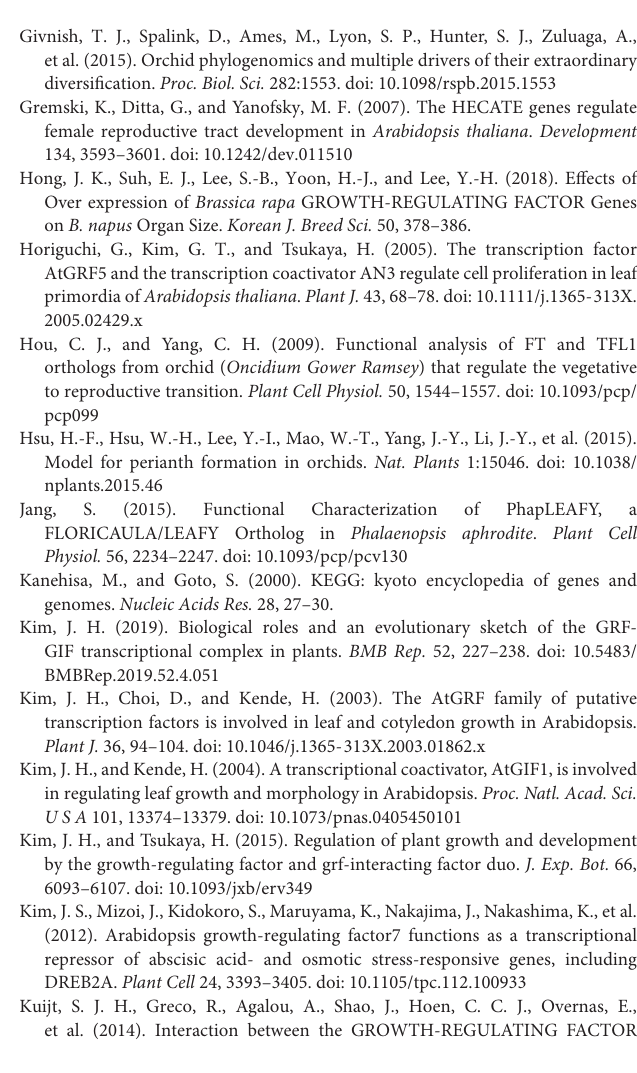
Supplementary Figure 1 | Floral development process of Cymbidium ensifolium. Supplementary Figure 2 | Comparative transcriptome analysis of individual floral Organs. (A) Transcripts differentially expressed between different floral organs. Up- and down-regulated transcripts were quantified. The results of six comparisons between each two samples are shown. Se, sepal; Pe, petal; Li, Lip; Co, column. (B) GO term classification of differentially-expressed unigenes. (C) Expression heat map of CeGRF genes in sepal, petal, Lip, and column. Expression values from RNA-seq data were log 2 -transformed and are displayed as filled blocks in blue to red indicating gene expression intensity from low to high. Supplementary Figure 3 | Detailed information for protein motifs predicted in CeGRFs. Supplementary Figure 4 | Phylogenetic analysis of CeGRFs and AtGRFs. Supplementary Figure 5 | Cymbidium ensifolium -miR396-regulated CeGRFs expression in a Cymbidium ensifolium protoplast-based transient expression system. Supplementary Figure 6 | Cymbidium ensifolium -miR396-regulated NtGRFs expression in transgenic tobacco